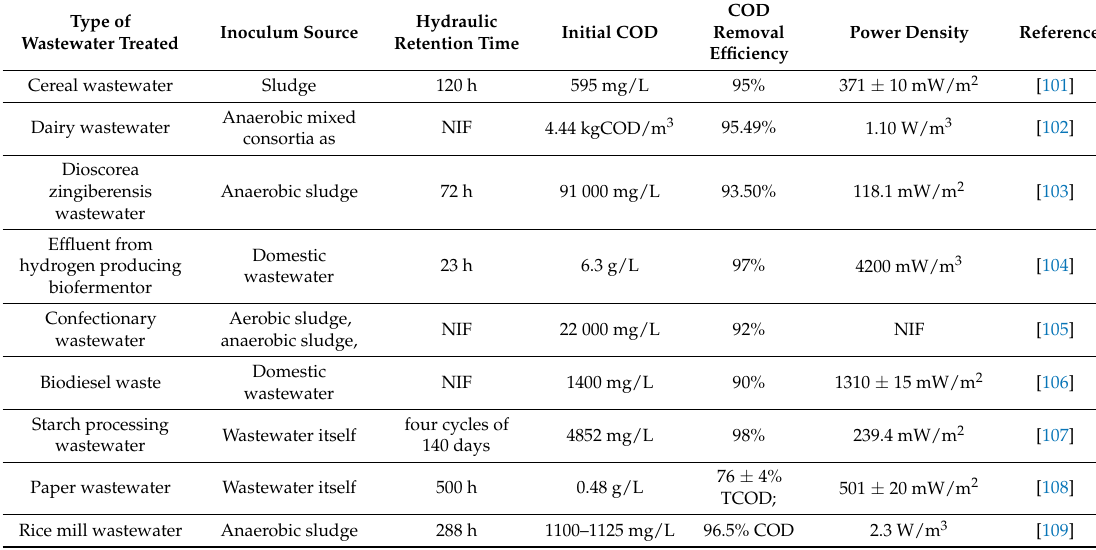
Table 3. Simultaneous wastewater treatment of various substrates, COD removal efficiency and power densities reported in the